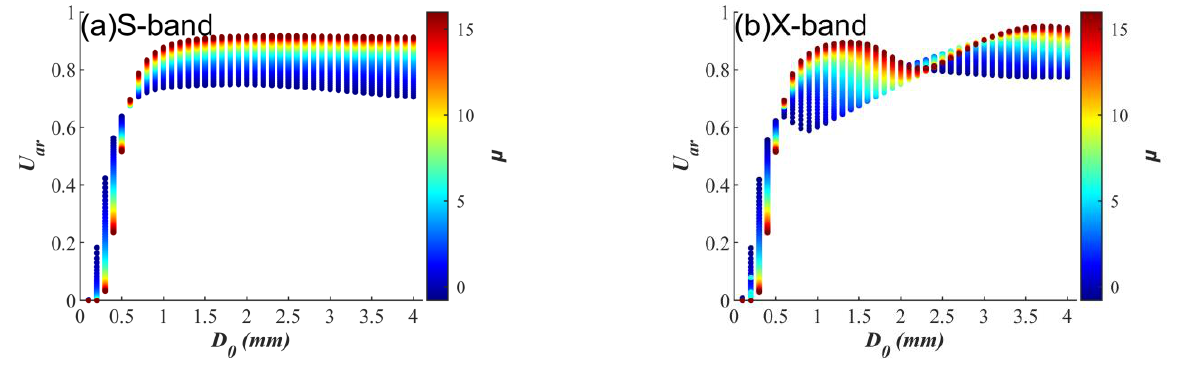
Figure 7. Relationships of U ar versus D 0 and μ when D max =10 mm. ( D max = 10 mm. The values of D 0 and μ are the same as those in Figure 5). ( a ) S-band, ( b ) X-band.